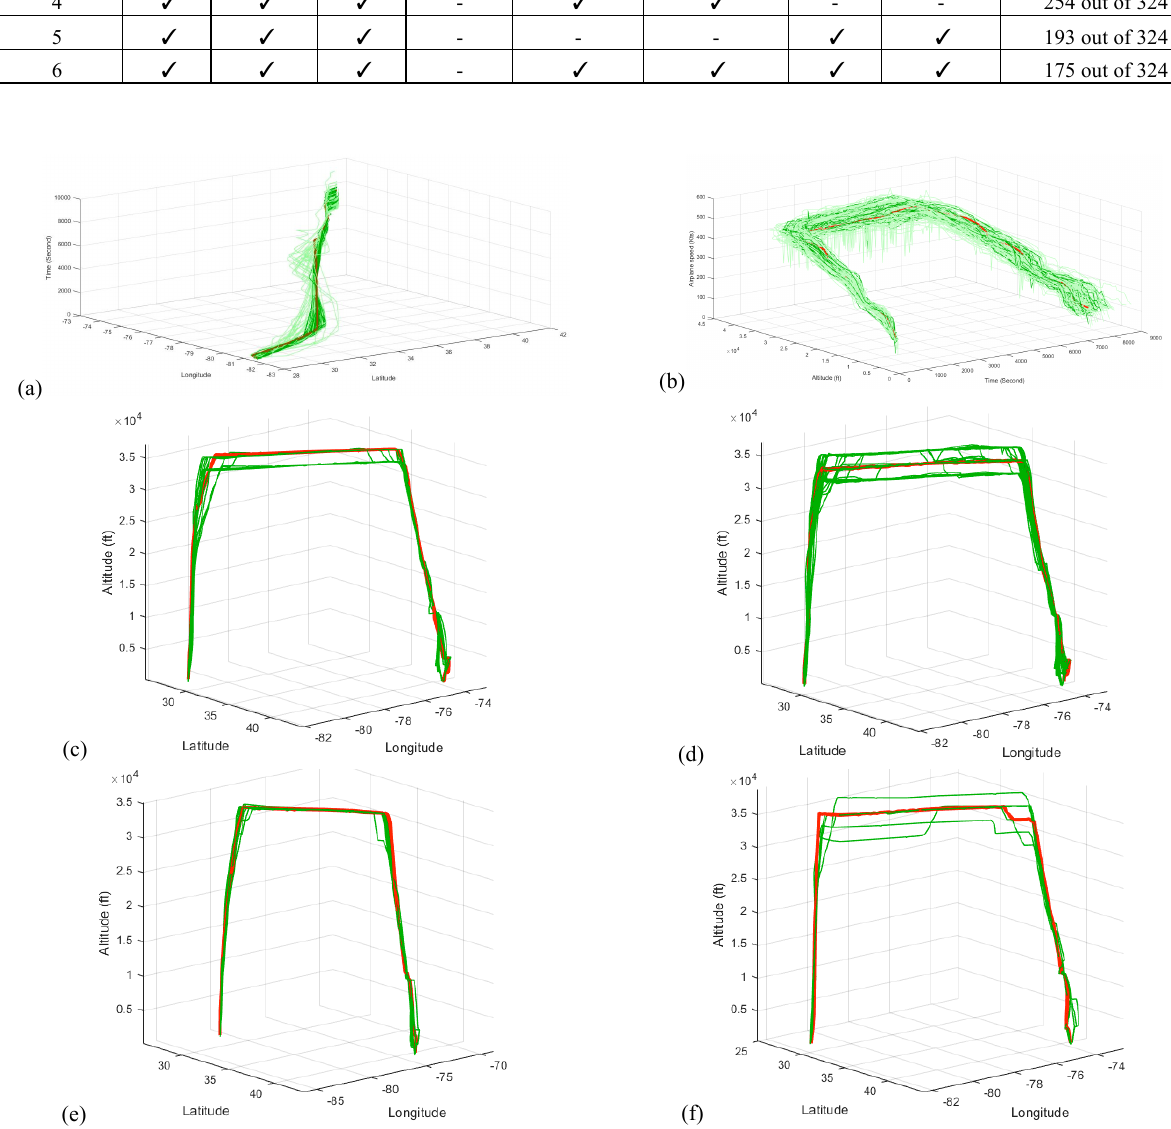
Figure 6. Discovered patterns (in dark green) from the dataset (in light green) based on the reference trajectory (in red): (a) latitude, longitude, and time; (b) Altitude, airplane’s ground speed, and time; (c) Boeing pattern; (d) Airbus pattern; (e) McDonnell Douglas pattern; (f) Embraer